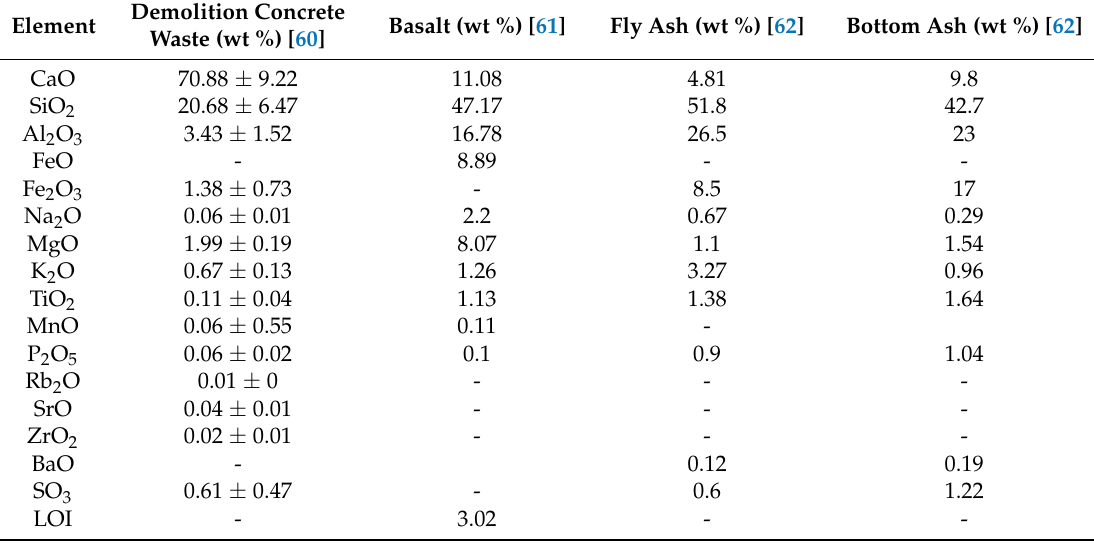
Table 1. Typical chemical composition of demolition concrete waste, basalt, and fly and bottom ash samples from